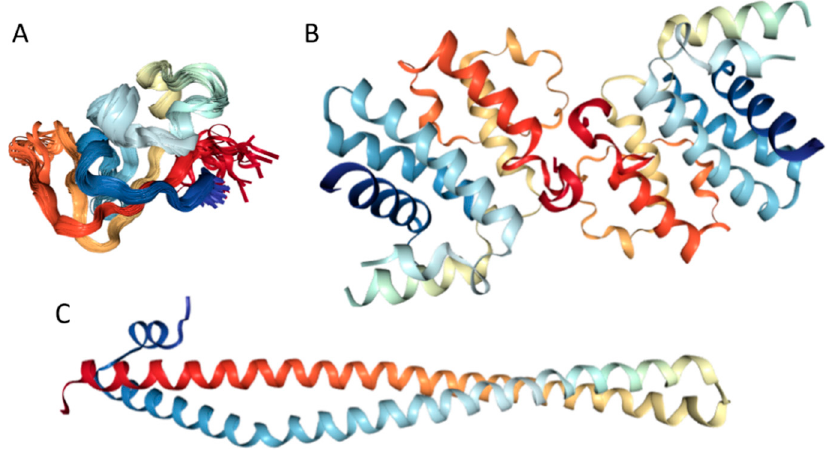
Figure 13. Structural characterization of human phosphoinositide 3-kinase regulatory subunits 2 (PIK3R2) protein. ( A ) Solution structure of the SH3 domain (residues 1–80, PDB ID: 2KT1). ( B ) Crystal structure of the dimeric form of the Rho-GAP domain (residues 108–298, PDB ID: 2XS6). ( C ) Crystal structure of the iSH2 domain (residues 433–610, PDB ID: 3MTT).